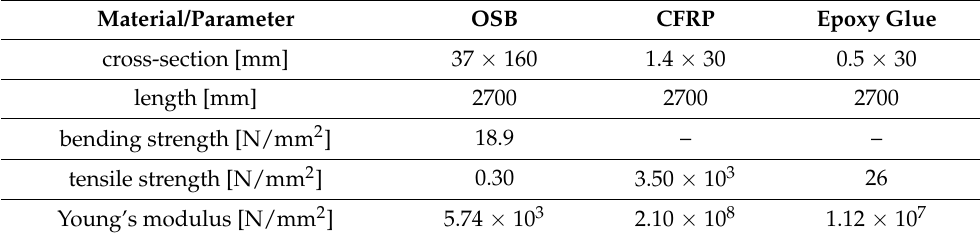
Table 1. Mechanical parameters of used materials (manufacturers’